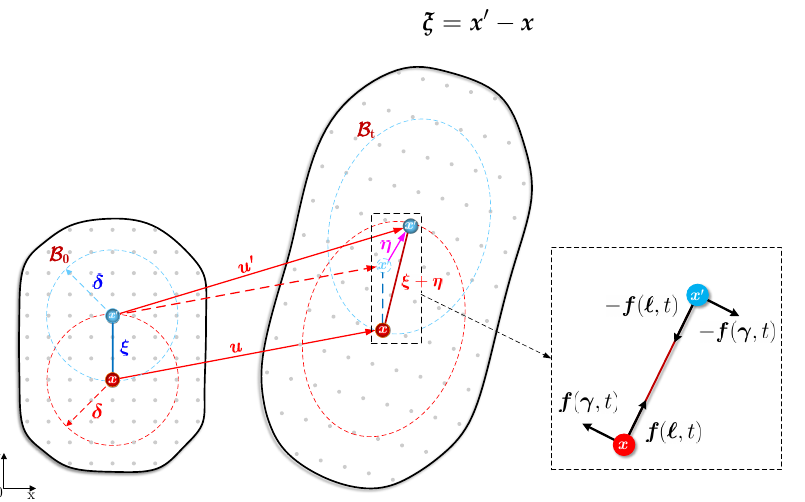
Figure 4. Schematic diagram of the extended bond-based peridynamic